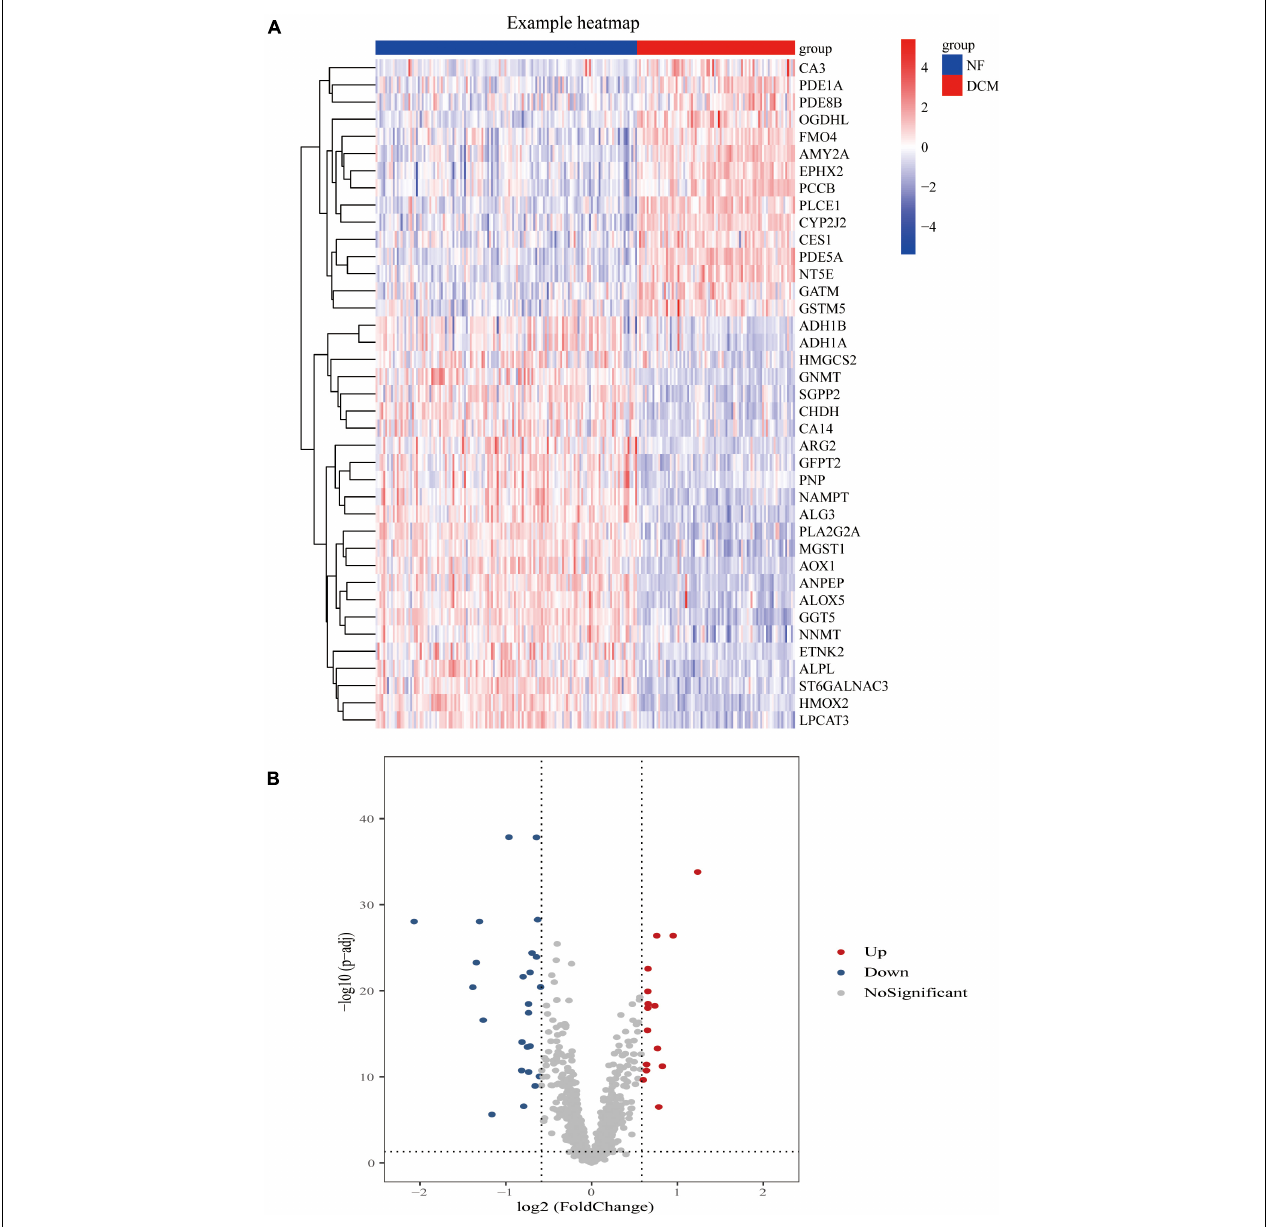
FIGURE 1 | Differential expression of feature metabolism-related genes in dilated cardiomyopathy (DCM) patients and non-failing (NF) donors. Heat map (A) and volcano map (B) of metabolic-related differential gene expression in left ventricular tissues of patients with DCM and NF donors.